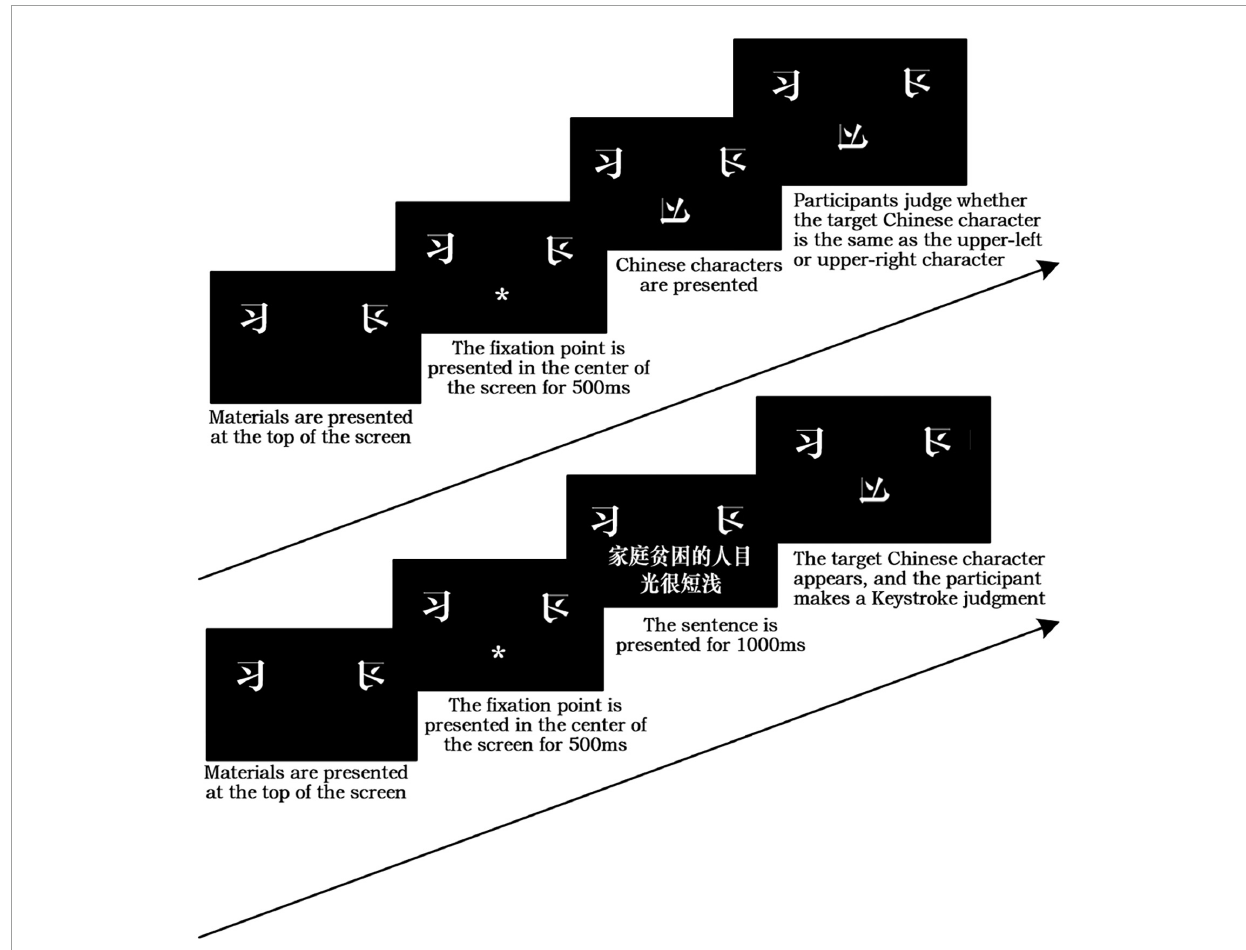
FIGURE1 Schematic diagram of the experimental group’s mental rotation task. *Representing the reminder to the participant that stimulus sentences will appear in this location.